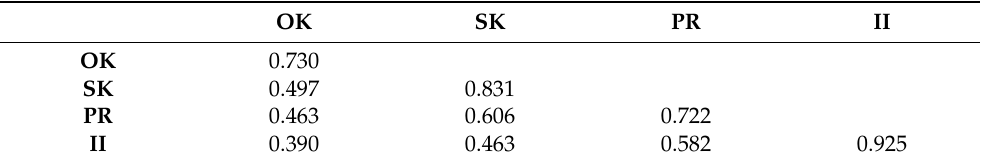
Table 4. Discriminant